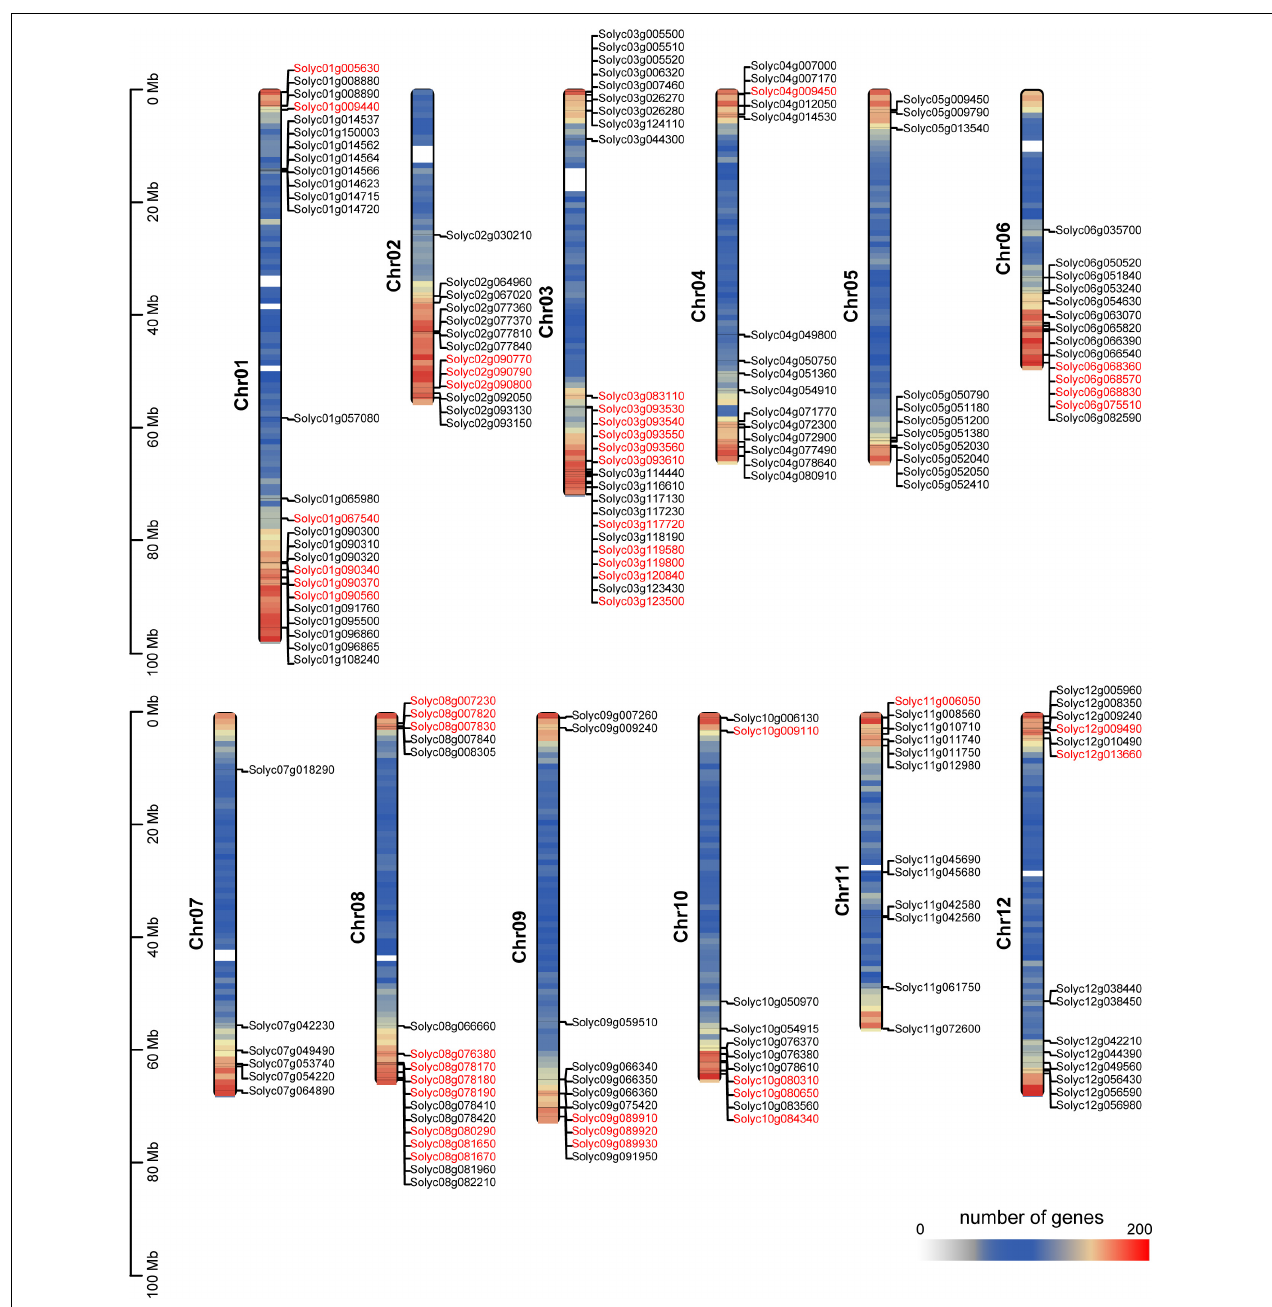
FIGURE 1 | Distribution of the identified 176 SlAP2/ERF genes across the tomato genome. The density of genes on 12 chromosomes are shown. All tomato chromosomes are drawn to scale based on their actual physical lengths. The genes with red color represent that they locate on domestication or improvement sweeps. The color of chromosomes represents the number of